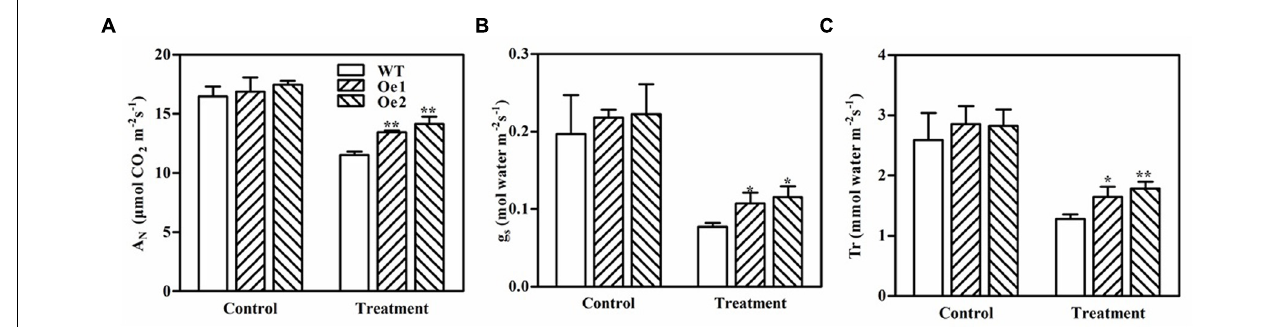
FIGURE 7 | Daily (A) net CO 2 assimilation ( A N ), (B) stomatal conductance ( g s ), and (C) transpiration rate ( T r ) of wild-type (WT) and GmPIP2;9 -overexpression (Oe) transgenic soybean plants under normal and drought stress conditions. Water was withheld from 40-day-old WT and GmPIP2;9 -Oe transgenic soybean plants for 11 days. An LI-6400 was used to measure A N , g s , and T r between 8 AM and 2 PM on day 11 of drought treatment. The parameters were measured in four different plants per treatment. Data are the means ± SD ( n = 4). ∗ P < 0.05 and ∗∗ P < 0.01.